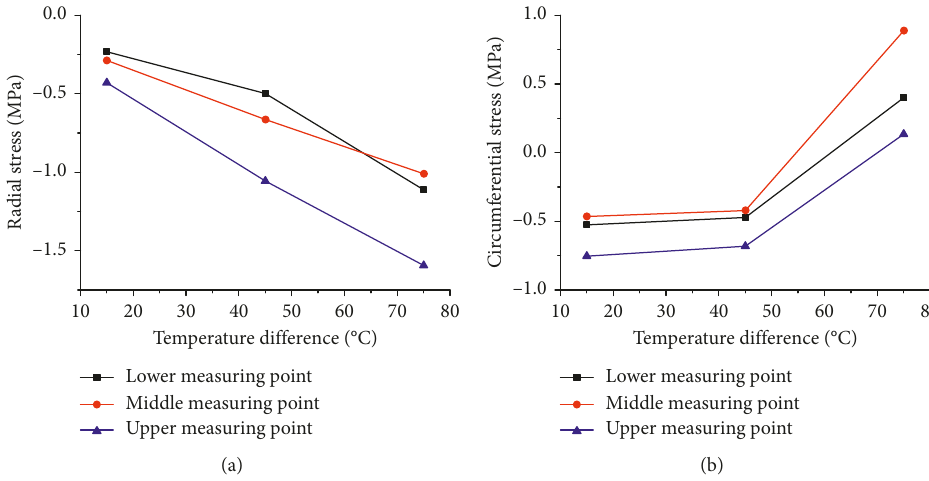
Figure 12: Maximum of thermal stress under different heating temperatures. (a) Radial stress. (b) Circumferential stress.